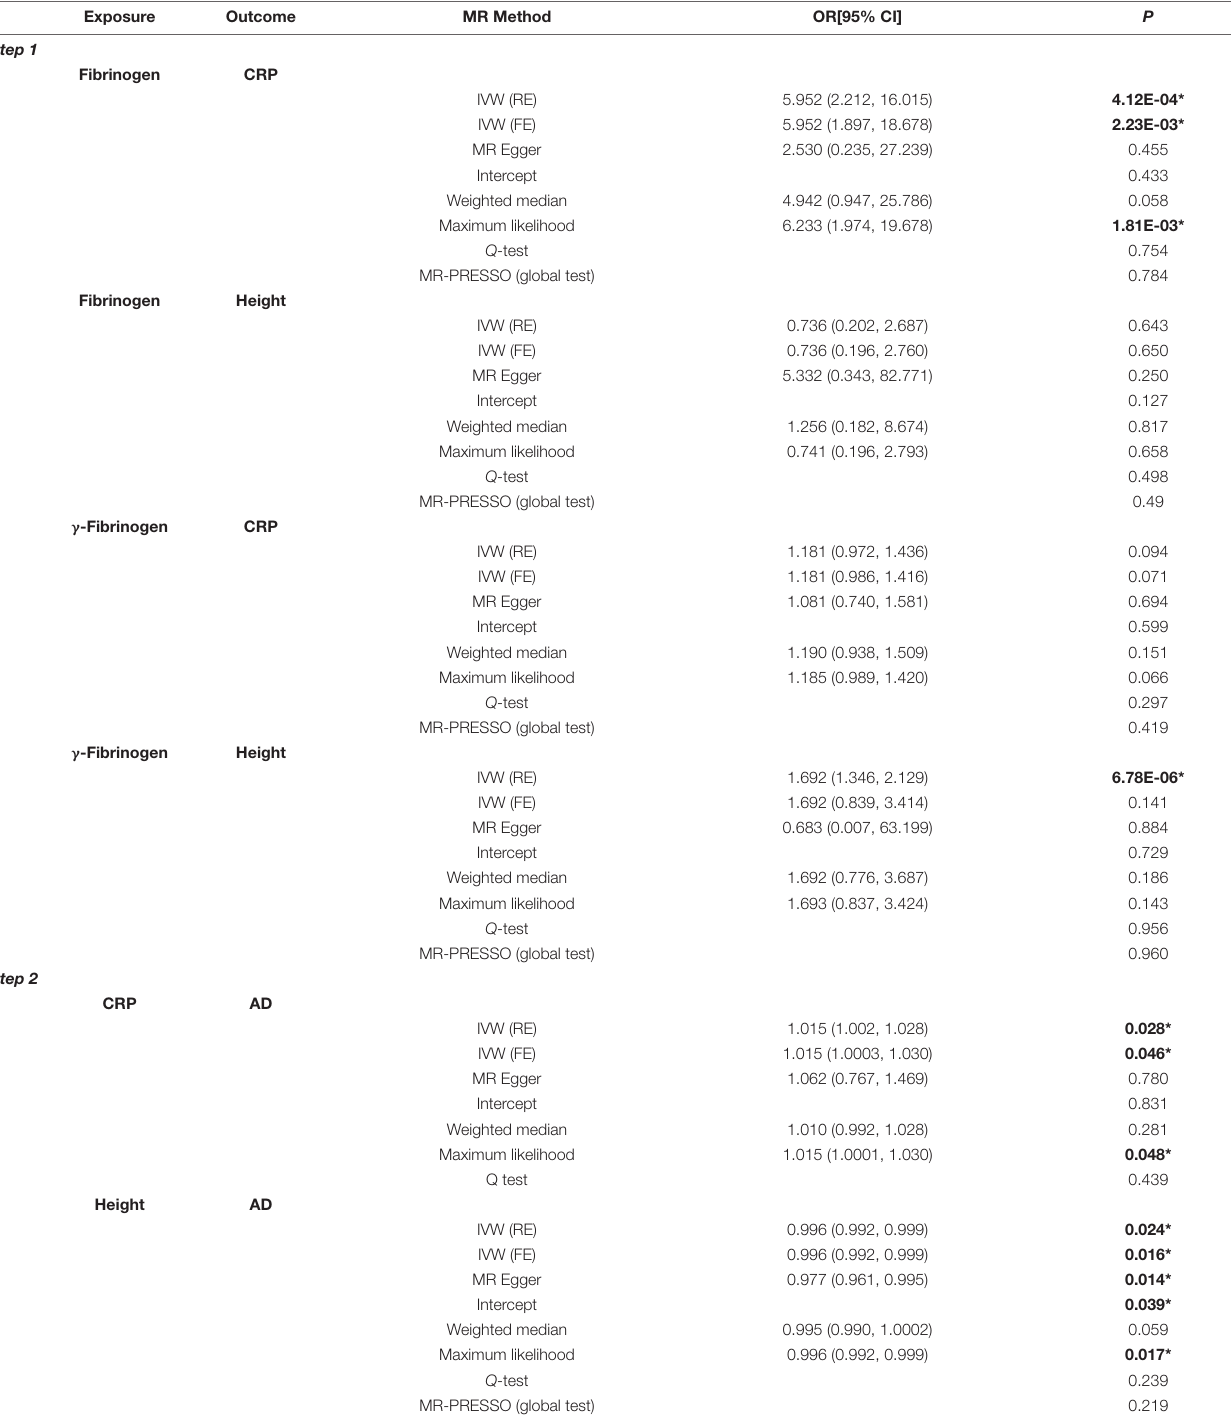
TABLE 2 | Results of two-step MR